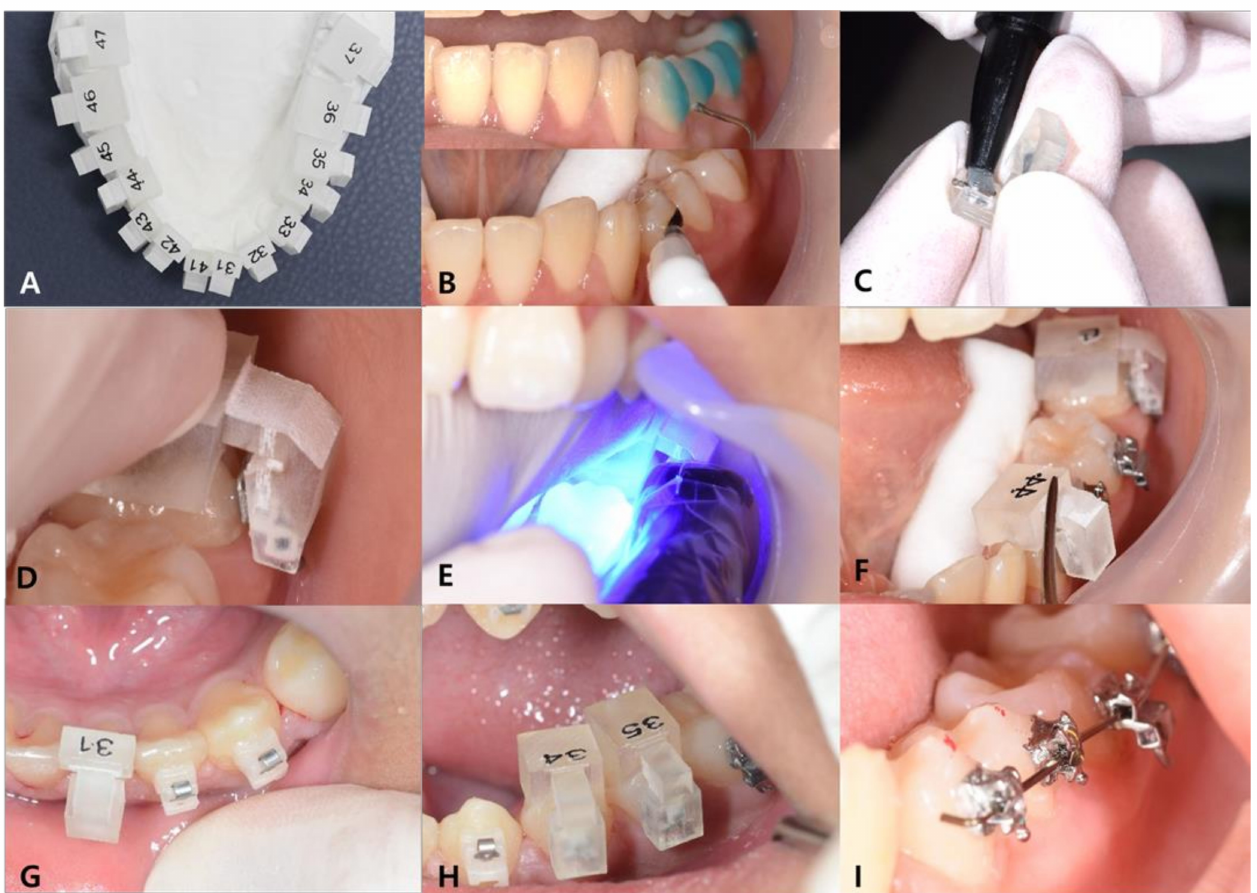
Figure 3. An example of an indirect bonding jig system (IDBS) transfer procedure. ( A ) Brackets transferred to the model by indirect bonding procedure using the jig system; ( B ) teeth surface etching; ( C ) placement of the orthodontic adhesive on the bracket; ( D ) placement of the bracket on the tooth and application of sustained and steady occlusal pressure; ( E ) curing the adhesive using light; ( F ) removal of the transfer jig; ( G , H ) bracket transfer using a one-body jig on the incisors and premolars, respectively; ( I ) checking and grinding the premature contact